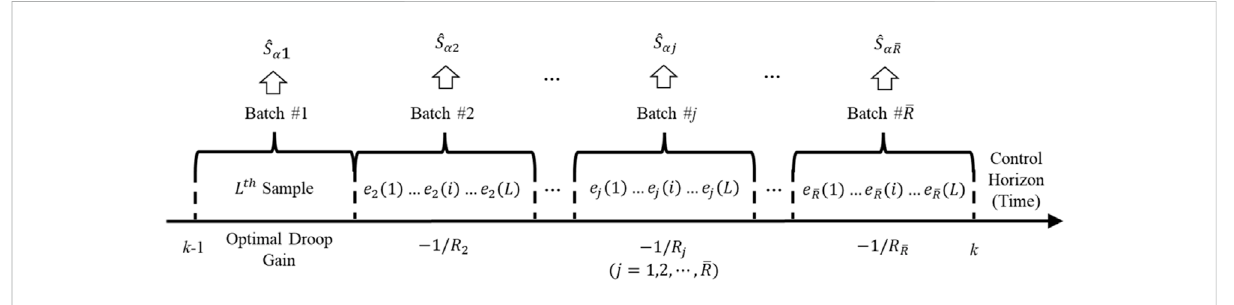
FIGURE 7 Additive control horizon.